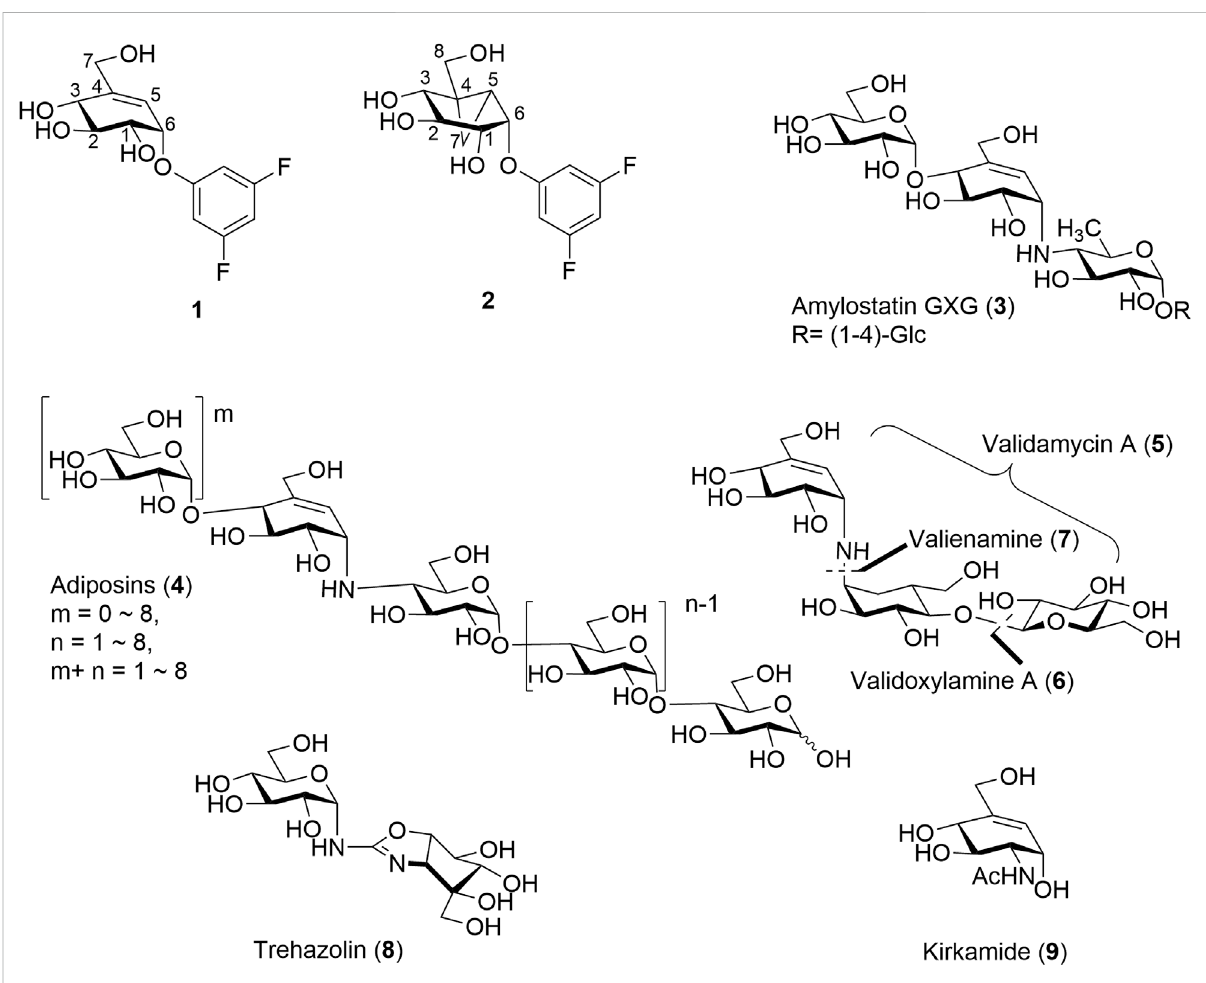
FIGURE 1 Previously isolated/synthesized C 7 /C 8 -cyclitols and C 7 N-aminocyclitols